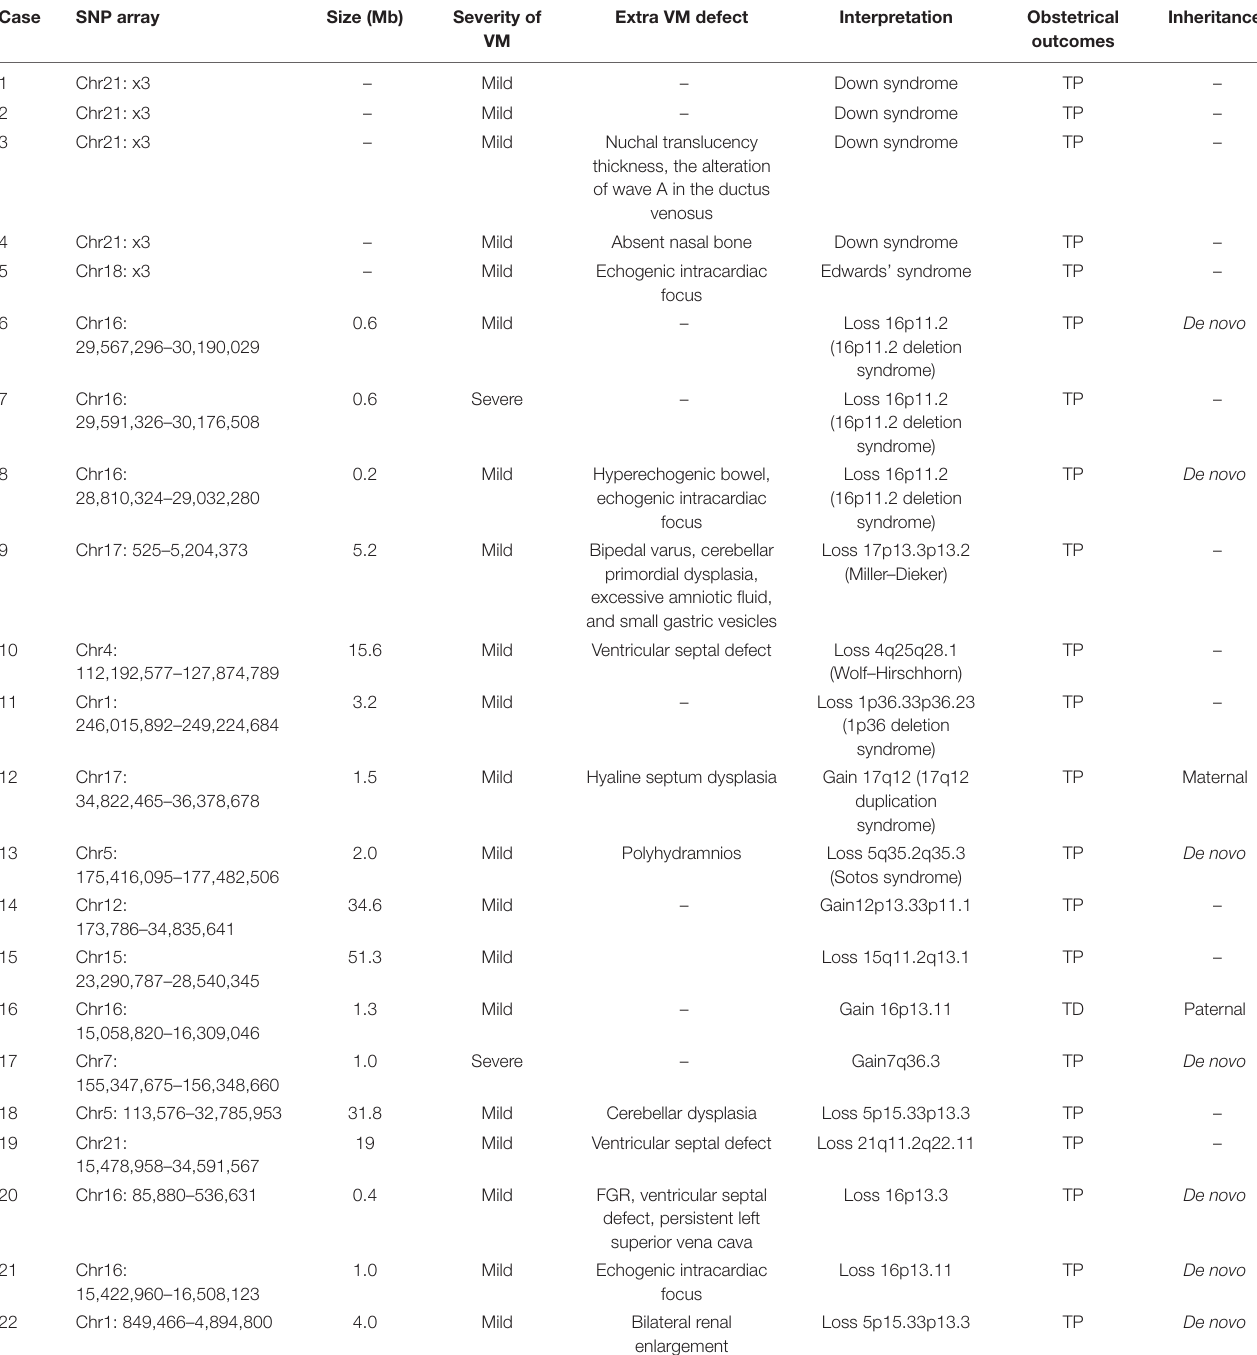
TABLE 2 | The pathogenic copy number variation in VM